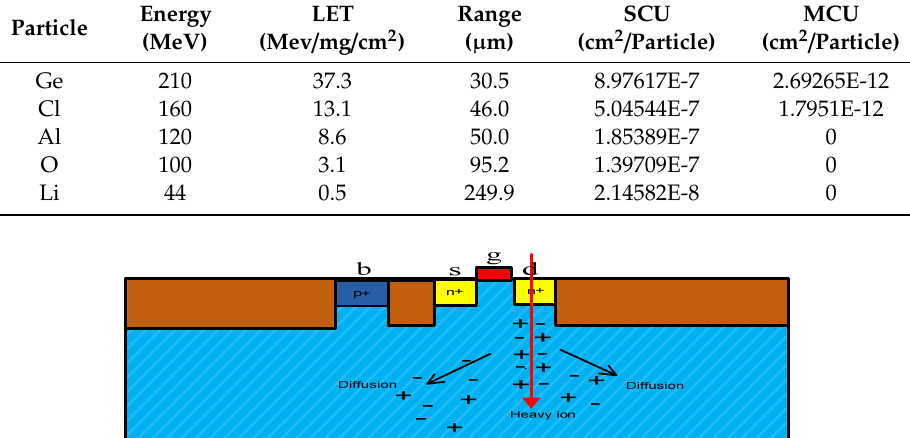
( b ) Figure 6. ( a ) Layout of the SRAM, ( b ) structural layout of the 6 transistors cell. The test was carried out with five heavy ions (Al, Cl, Ge, Li, and O) for the 40 nm technology node. Particle LET values were from 0.5 to 37.3 MeV cm 2 /mg. The range of particles in silicon was 30.5–249.9 μ m. Table 1 contains the particle beams, particle LET values, particles energy, ranges in